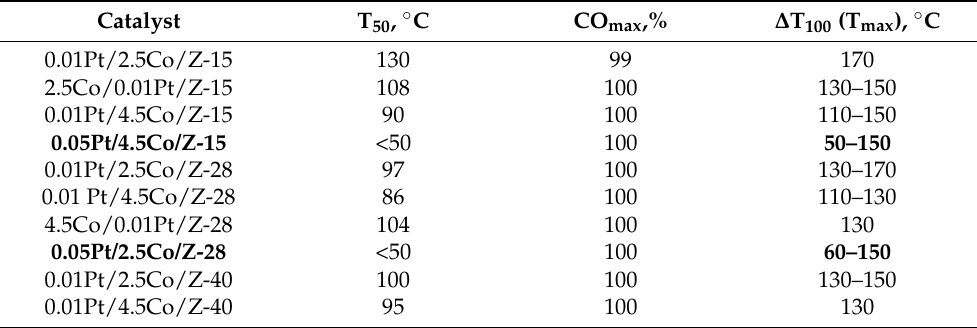
Table 5. The main catalytic characteristics of Pt/Co-modified zeolites: the temperatures correspond- ing to 50% and maximum conversion of CO (T 50 and T max , respectively) and temperature range to maintain 100% СО conversion (ΔT 100 ).